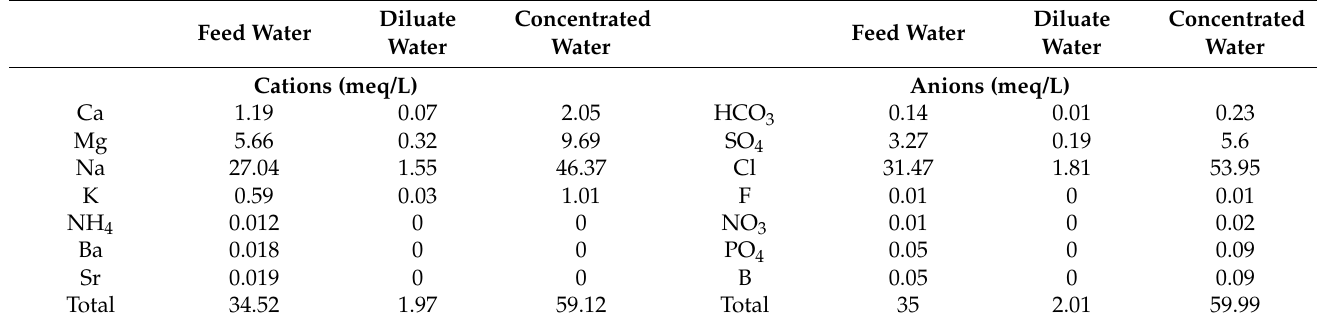
Figure 11. Desalination of the 5000 mg/L TDS samples at the chosen temperatures and initial concentrations. Table 7. Mass balance of the experiments at 2000 mg/L, 35 ◦ C, and 20 V.